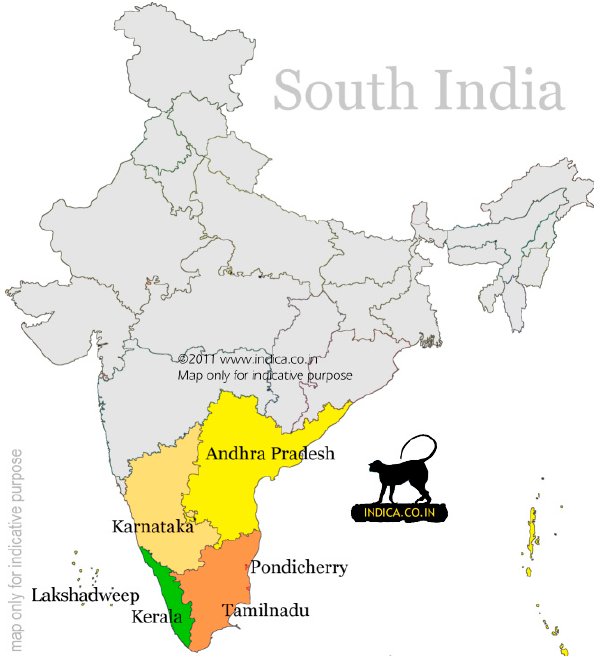
Figure 1. Map of India. The south Indian states are Andhra Pradesh, Tamil Nadu, Karnataka and Kerala. (https://visimaps.blogspot.com/2016/04/south-india-map.html, accessed on 13 February 2021).